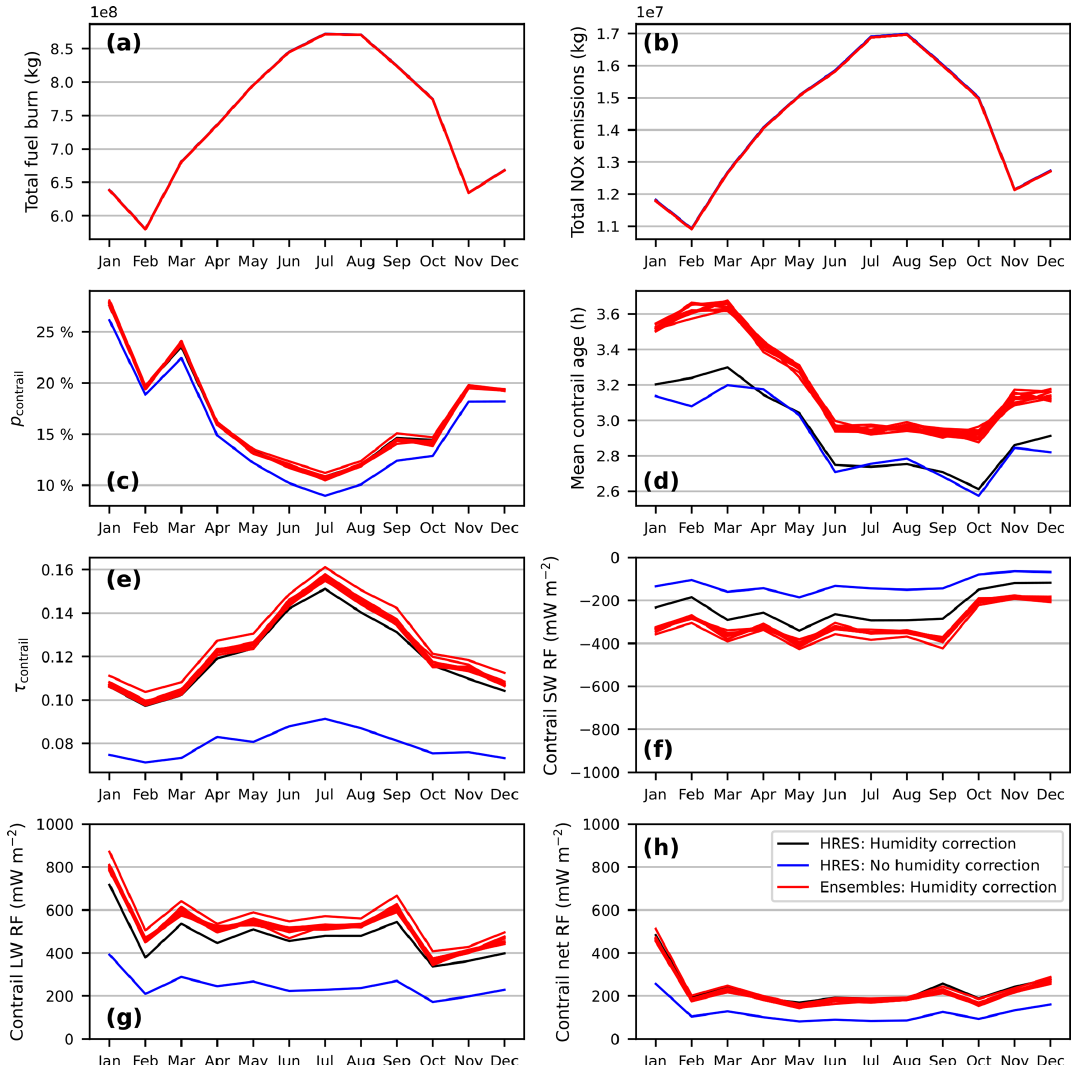
Figure 6. Uncertainty and sensitivity analysis comparing the emissions and contrail statistics in the North Atlantic region for 2019. Contrails are simulated using meteorological data from the ERA5 HRES with humidity correction (as outlined in Sect. 2.2; black lines), data from the ERA5 HRES without humidity correction (blue lines) and data from the ERA5 10-member ensemble with humidity correction, where individual red lines represent the results for each ensemble